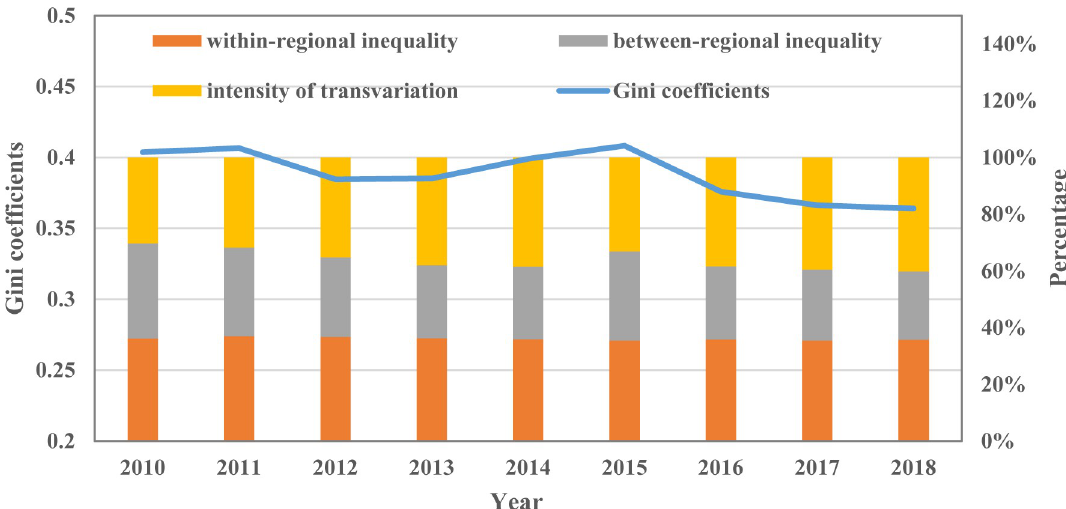
Fig 8. The spatial difference in per capita carbon emissions from civil